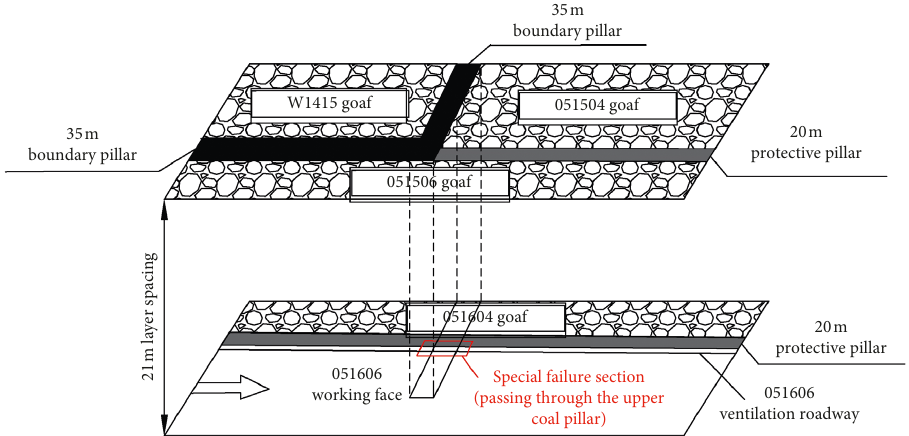
Figure 1: The relationship of space arrangement between the 051606 working face and the upper coal.